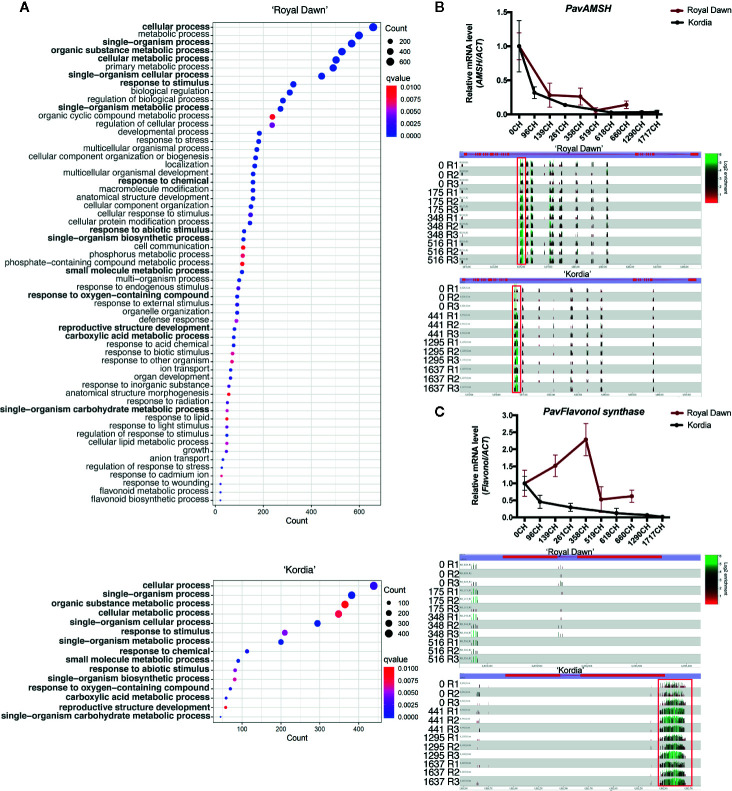
Enrichment of differentially expressed genes that negatively correlated (r <–0.5) with methylation levels during chilling accumulation. (A) Gene Ontology terms (p-value <0.01) of biological processes from DEGs associated with DMRs in ‘Royal Dawn’ and ‘Kordia’. The mechanisms in bold represent conserved mechanisms between varieties and the dot size indicates the number of genes as counts. (B) Transcript (above) and DNA methylation level (below) of a DMR of approximately 300 bp in an intron of PavAMSH (Pav_sc0001014.1_g060.1.mk), gene from the ‘cellular process’ mechanism that was methylated in both varieties. Transcripts are represented as qPCR analysis and gene methylation as enrichment levels from Seqmonk visualizer, where green peaks indicate high levels and black to red indicate low levels of methylation. (C) Differential regulation of PavFLAVONOL SYNTHASE (Pav_sc0000030.1_g1340.1.mk), gene from the mechanism ‘response to abiotic stimulus’, being methylated in approximately 300 bp of its 3’ end. Transcripts are represented as qPCR (above) and DNA methylation as enrichment (below).